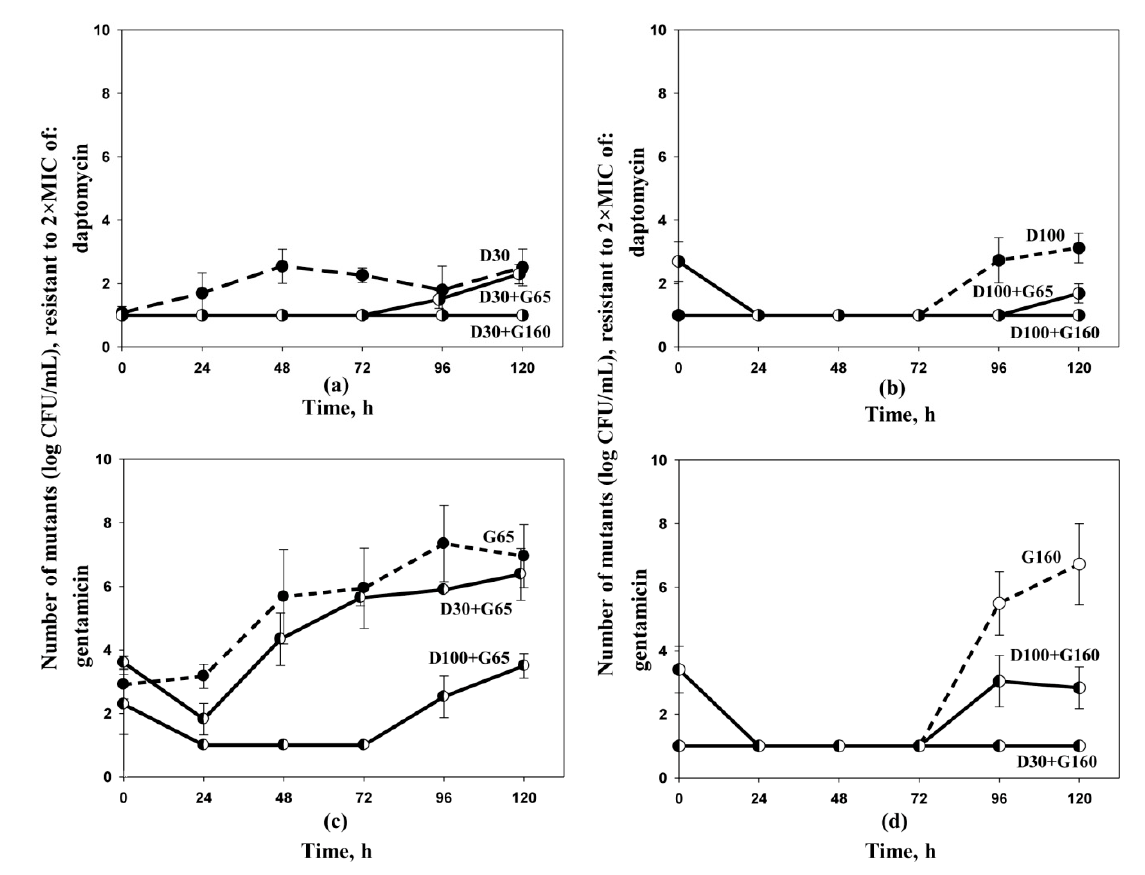
Figure 2. Time courses of subpopulations of S. aureus 293, resistant to 2 × MIC of daptomycin ( a , b ) and gentamicin ( c , d ). Dosing regimens are indicated at each curve. Data are presented as arithmetic means ± standard deviations.